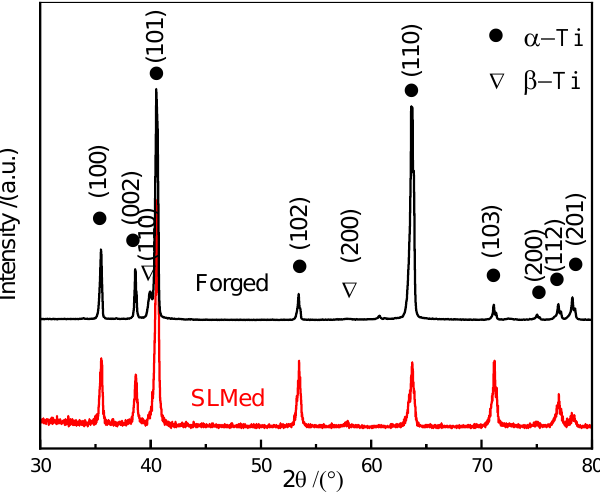
Figure 2. X-ray diffraction (XRD) patterns of the tested Ti-6Al-4V alloys. The microstructure of the Ti-6Al-4V alloy is displayed in Figure 3. It can be clearly seen from Figure 3a that the microstructure is composed of a bright primary α phase (α p ) and dark β transformed structure (β t ). In addition, there are also α p phases dispersedly distributed within the β t phase. As seen in Figure 3b, a large amount of a lath secondary α phase (α s ) is observed within the β t matrix.